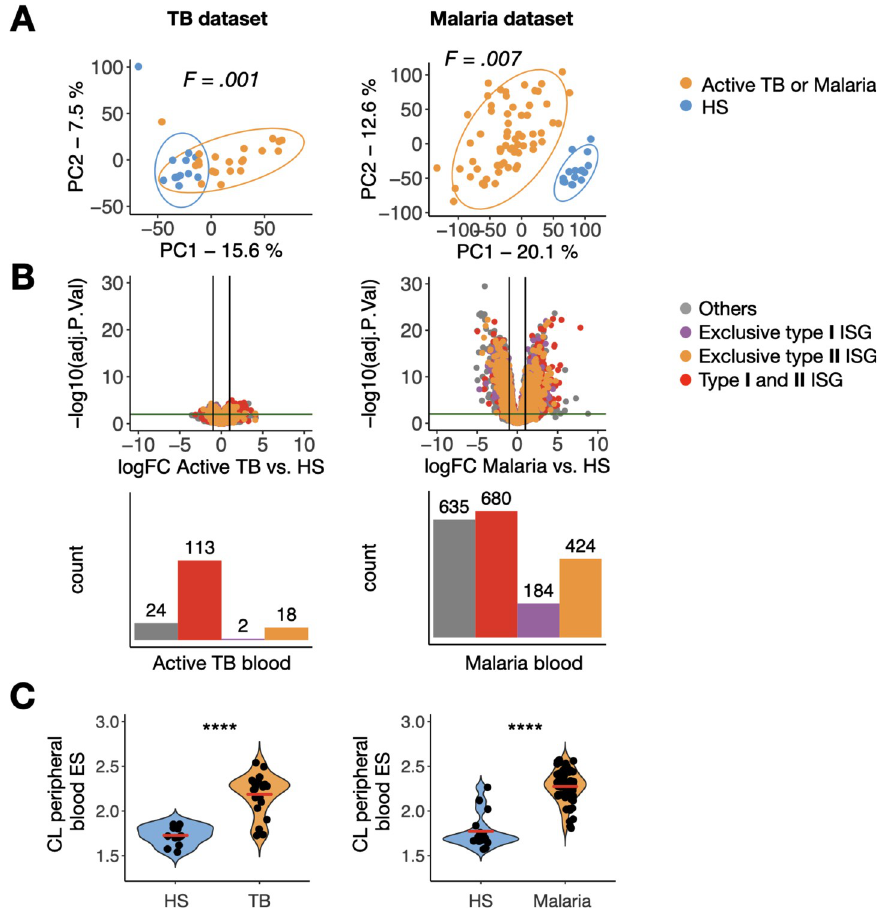
Fig 5. A peripheral blood signature of cytotoxicity distinguishes CL from malaria and TB patients. (A) Principal component analysis showing principal component 1 (PC1) and PC2 for RNA-seq data from the peripheral blood of patients with active tuberculosis (left, n = 21) and malaria (right, n = 65) and study controls (HS in blue, n = 12 and n = 16, respectively). (B) Top, Volcano plots showing DEGs in TB and malaria, with type I and II ISGs indicated (horizontal and vertical lines denote FDR = 0.01 and logFC = 1, respectively). Bottom, the number of overrepresented genes in the blood of active TB and malaria patients. (C) CL peripheral blood enrichment score per sample in the TB dataset and malaria dataset by ssGSEA. Wilcoxon rank-sum test was used for statistical analysis. ���� P < 0.0001; ns,